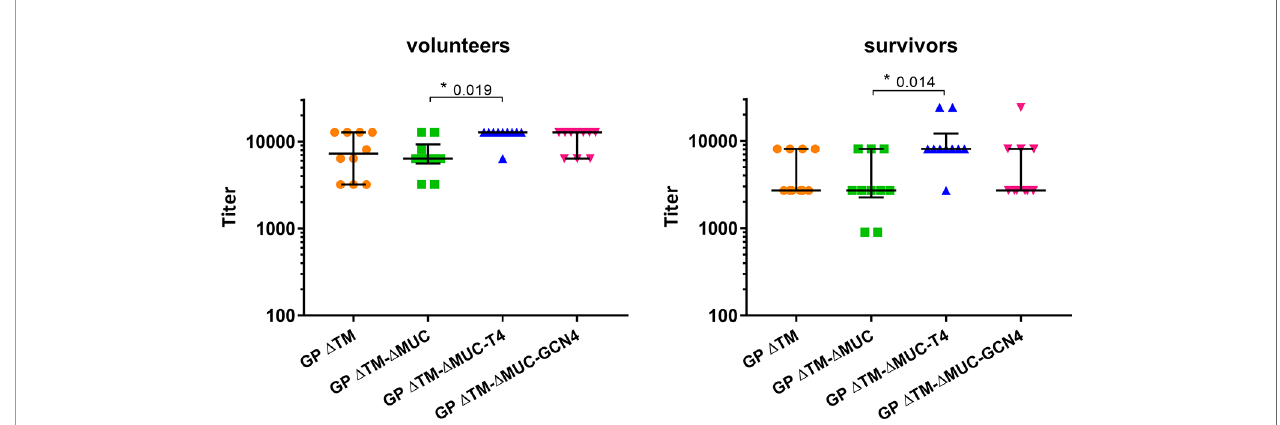
FIGURE 6 | The T4 trimer is mostly recognized by sera of clinical trial volunteers and Ebola disease survivors. A panel of 10 sera derived from clinical trial volunteers (left graph) and a panel of 10 Ebola virus survivors (right graph) were analyzed in direct ELISAs to test the recognition of GP D TM, GP D TM- D MUC, GP D TM- D MUC- T4, and GP D TM- D MUC-GCN4. Median values are shown together with interquartile ranges. Differences among groups were analyzed with a Kruskal-Wallis one-way ANOVA for multiple comparisons.